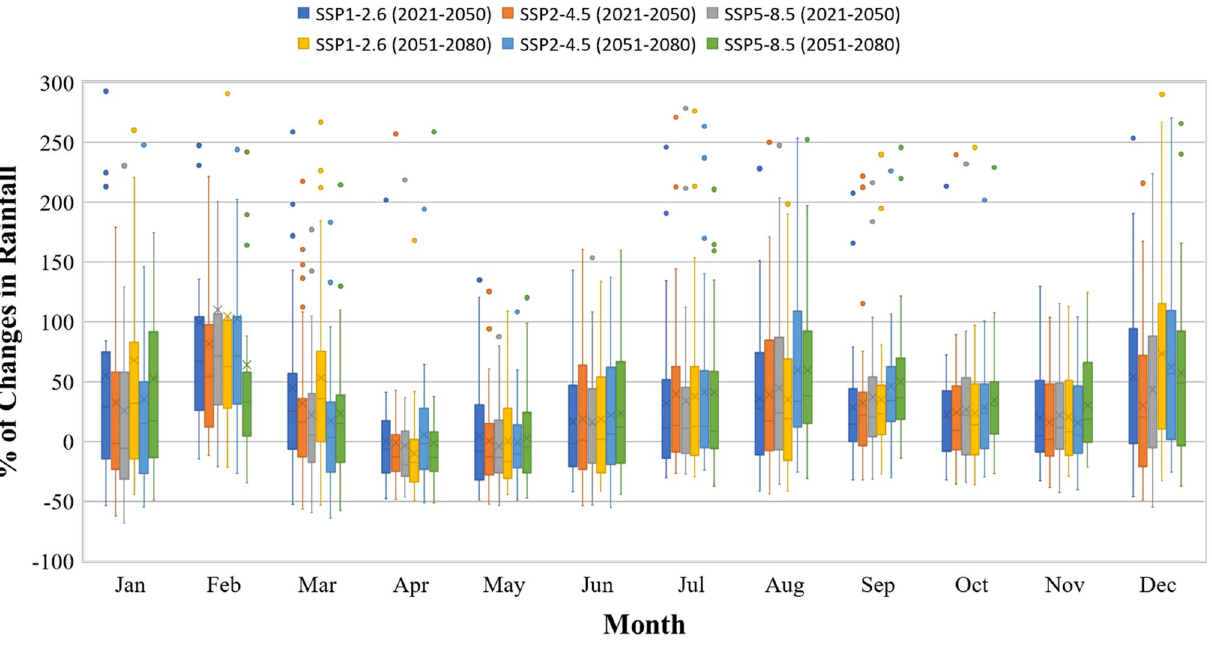
Fig. 7 Percent of changes of projected ensemble mean monthly rainfalls under SSP1-2.6, SSP2-4.5, and SSP5-8.5 scenarios for future periods 2021–2050 and 2051–2080 and with respect to baseline period of